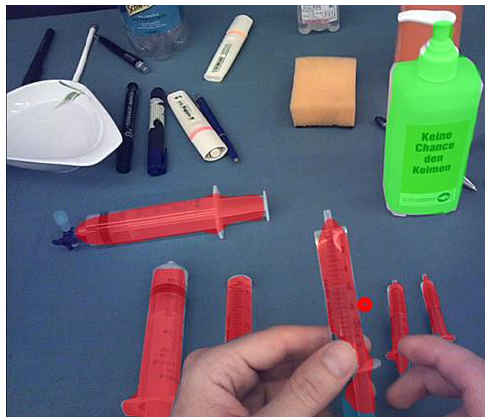
Figure 3: Detection of the two objects syringe and bottle by the cGOM algorithm. The detected objects are marked with masks, coloured according to the object class. Their positions in the image are then compared with the corresponding gaze point coordinate (red